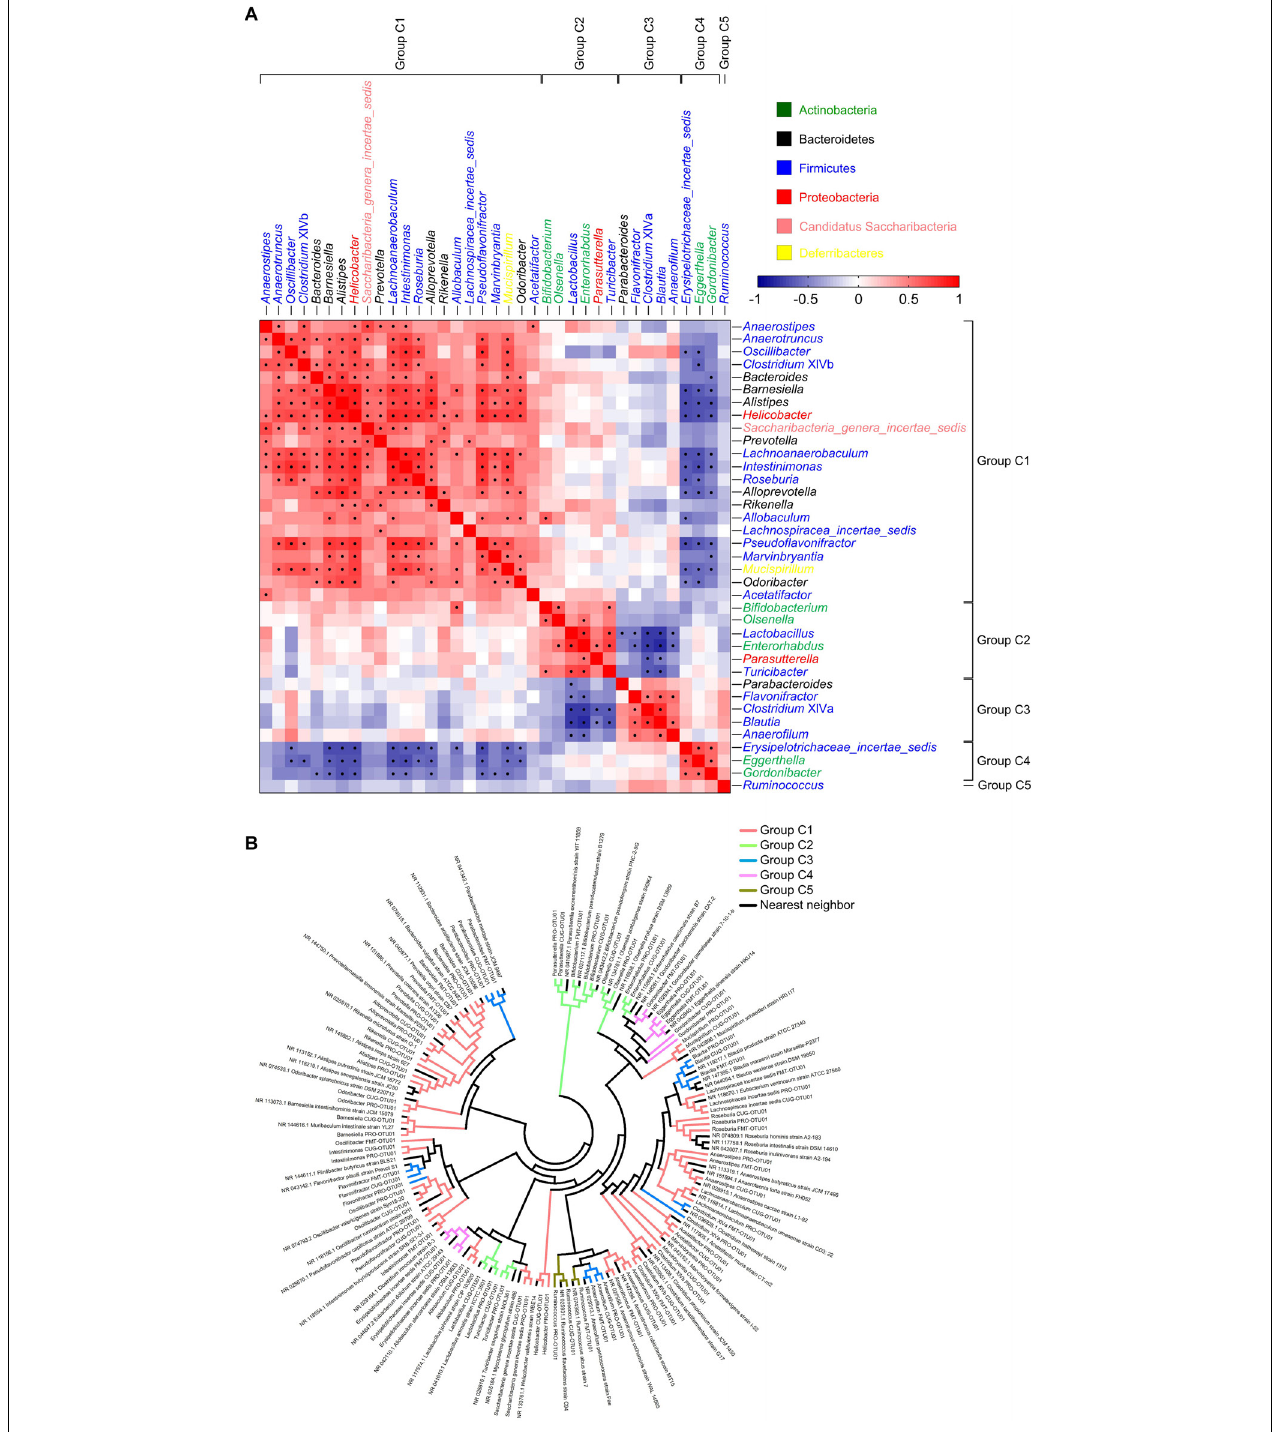
FIGURE 2 | The 37 core genera were classified into five potential core groups by co-abundance analysis. (A) Interaction patterns of the 37 core genera across the 101 samples determined by Spearman correlation analysis. Rows and columns corresponded to the 37 core genera. These genera were with the names shown on the right and top, colored according to phylum, and grouped based on the co-abundance. Red and blue color denoted positive and negative association, respectively. The color intensity represented the degree of association. The black dots in the red/blue cells indicated the associations were significant (0.5 < | r | < 1, and false discovery rate < 0.001). In each core group, the genera were showed in order of prevalence. (B) Phylogenetic reconstruction of sequences to the 37 core genera. The most abundant OTUs (OTU01) of the 37 core genera in each dataset and their nearest neighbors were chosen to construct this neighbor-joining tree using Mega 7. The clades were colored according to the five core